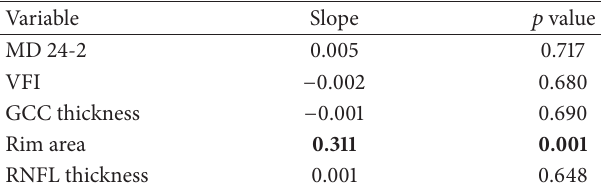
Table 7: Multivariate model for temporal disc vessel density 𝑅 2 = 0.390